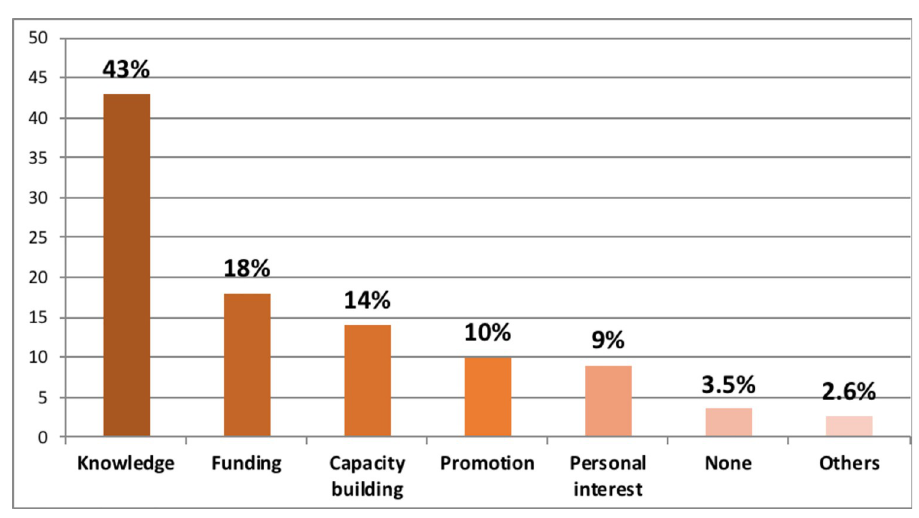
Fig 2. Incentives to conduct